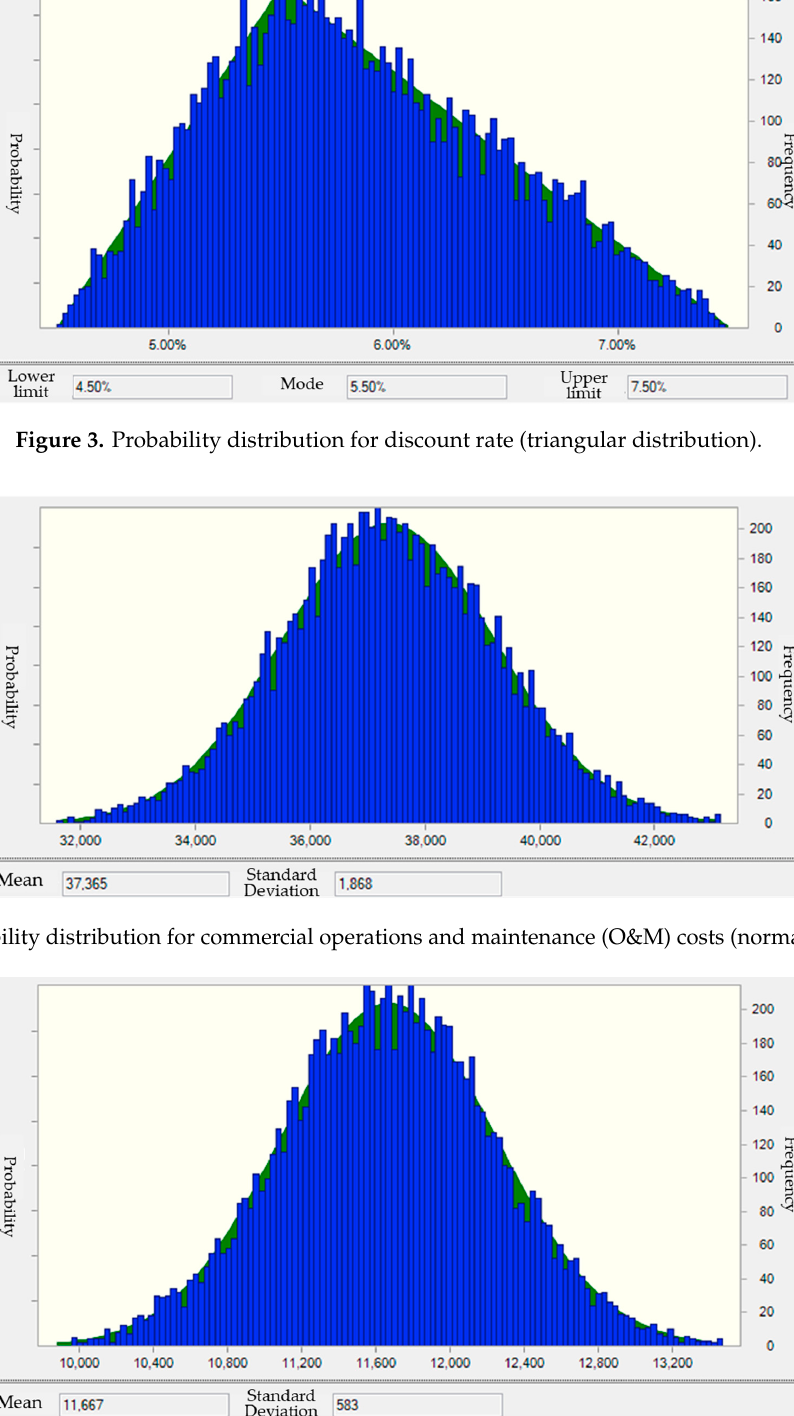
Figure 4. Probability distribution for commercial operations and maintenance (O&M) costs (normal distribution). Figure 5. Probability distribution for residential O&M costs (normal distribution).